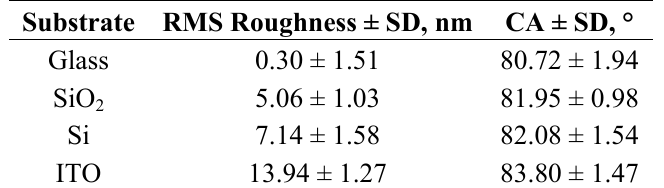
Table 6. RMS roughness and CA values of pp–GT thin films deposited on different